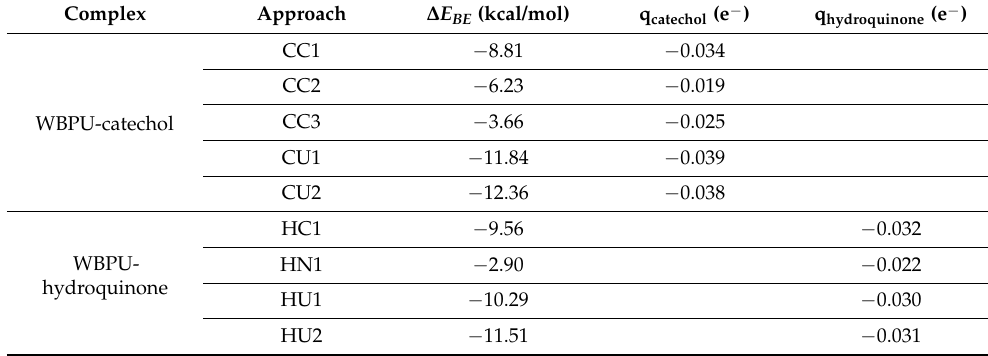
Figure 5. Hydroquinone binds with WBPU through four approaches. Two approaches (HC1 and HN1) for binding with the urethane group and two approaches (HU1 and HU2) to bind with the urea group in WBPU. The inside figure is a close view of the interaction between hydroquinone and WBPU with atom levels. Table 2. Complex formation binding energy ( ∆ E BE) ), charge transferred by catechol (q catechol ) and